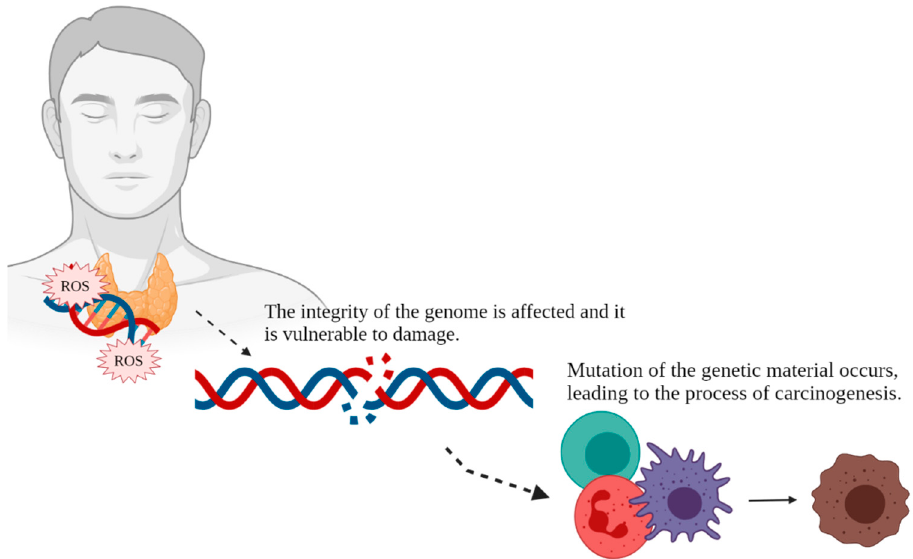
Figure 3. Free radical-mediated carcinogenesis in thyroid cancer. Created with BioRender.com. (accessed on 5 July 2021)